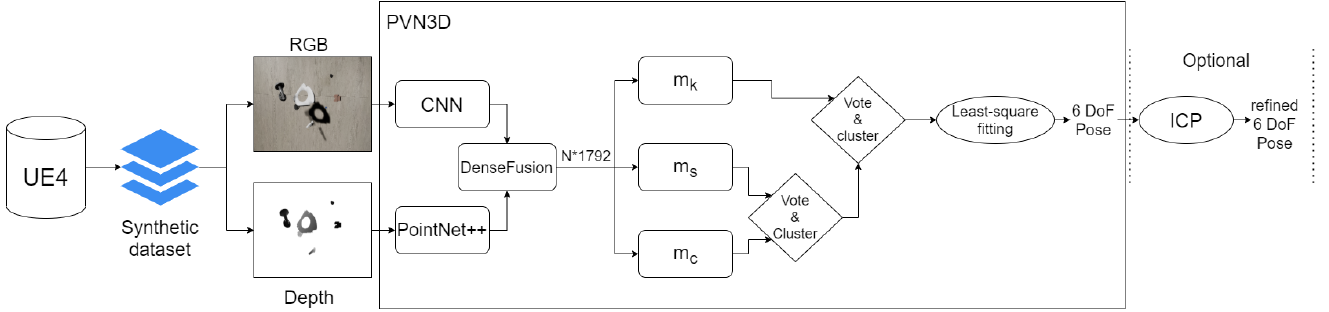
Figure 4. Perception module